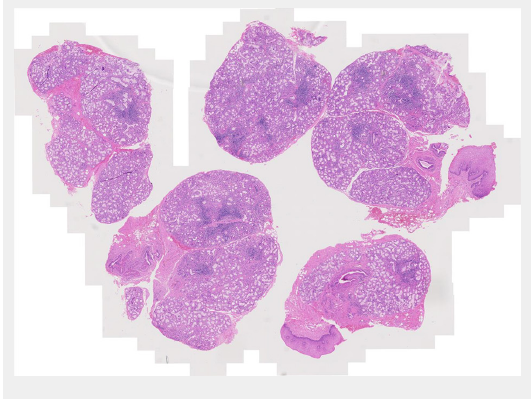
Haematoxylin and eosin staining of salivary gland biopsy section showing several periepithelial mononuclear cell infiltrates, i.e. focal lymphocytic